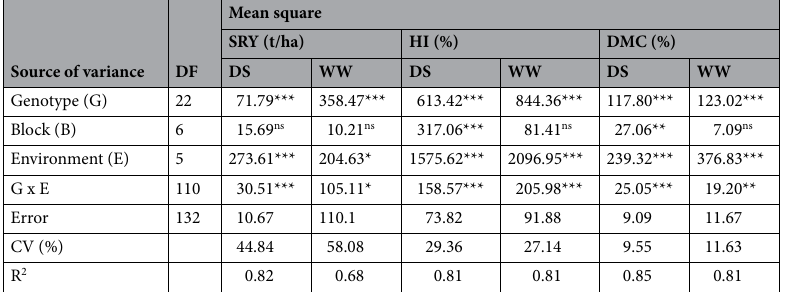
Table 3. Combined analysis of variance of storage root yield, harvest index and dry matter in multi- environment testing under drought stress and irrigation. *Significant at 5%, **Significant at 1%, ***Significant at 0.1%, ns not significant, DF degree of freedom, SRY storage root yield, HI harvest index, DMC dry matter content, DS drought stress, WW well-watered, CV coefficient of variation, R 2 R-square.